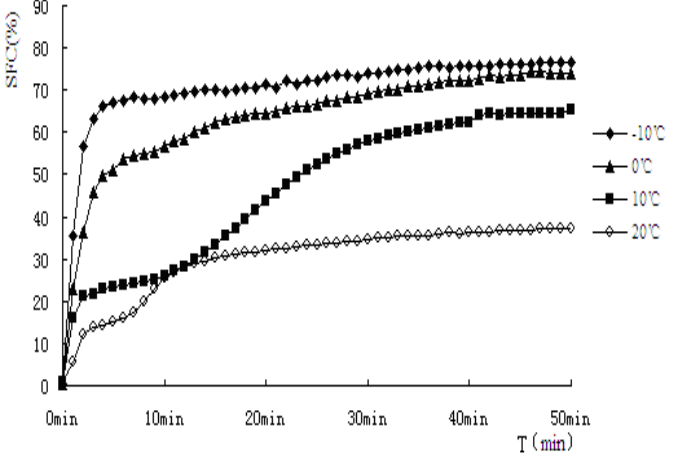
Figure 5. Solid fat content vs. time of crystallization for PS.